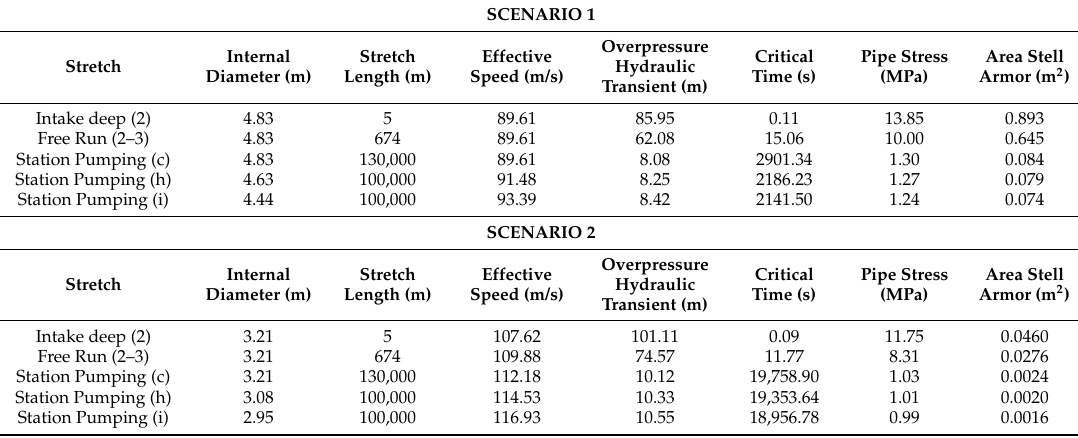
Table 12. Characterization of hydraulic transients for pipeline Huanghe/Dalian-China. Scenario 1 (200 L/capita/day), Scenario 2 (81 L/capita/day).